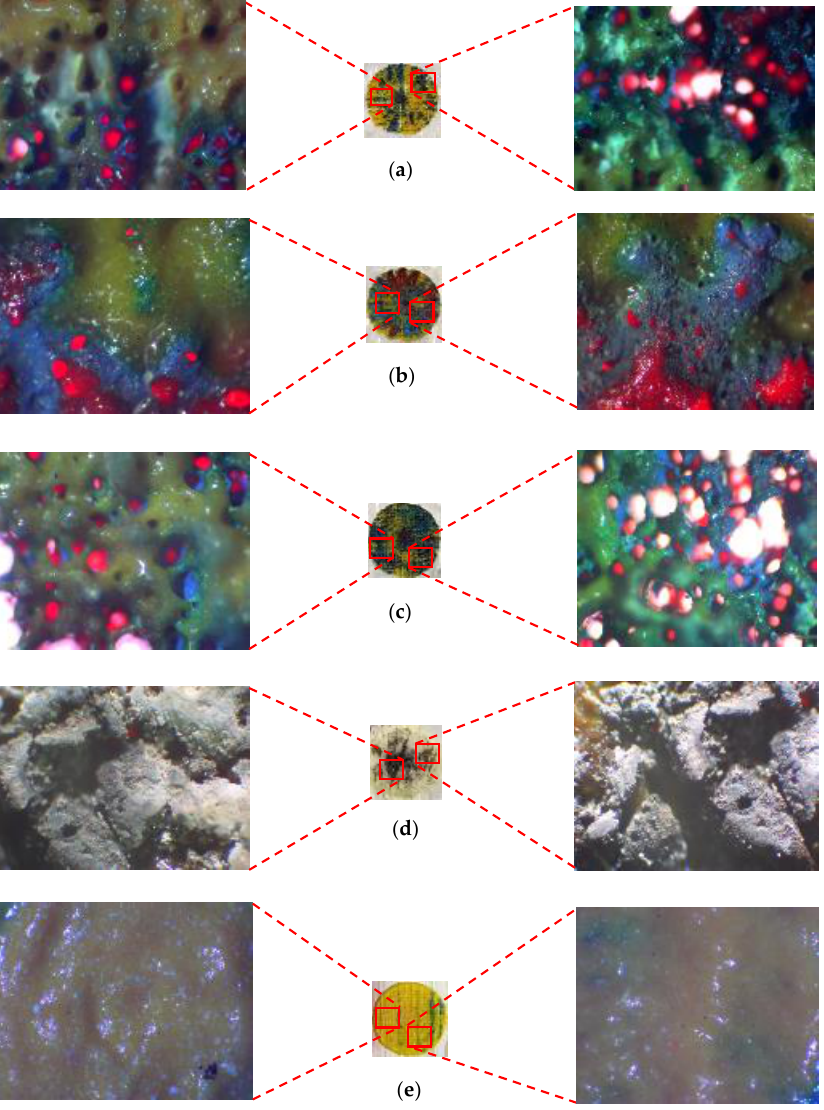
Figure 15. Results for different laser parameters: ( a ) P = 3.2 W, V = 100 mm/s, SOD = 50.8 mm; ( b ) P = 2 W, V = 50 mm/s, SOD = 50.8 mm; ( c ) P = 4.8 W, V = 33.33 mm/s, SOD = 50.8 mm; ( d ) P = 0.8 W, V = 16.66 mm/s, SOD = 47.8 mm; and ( e ) P = 0.4 W, V = 6.66 mm/s, SOD = 52 mm.